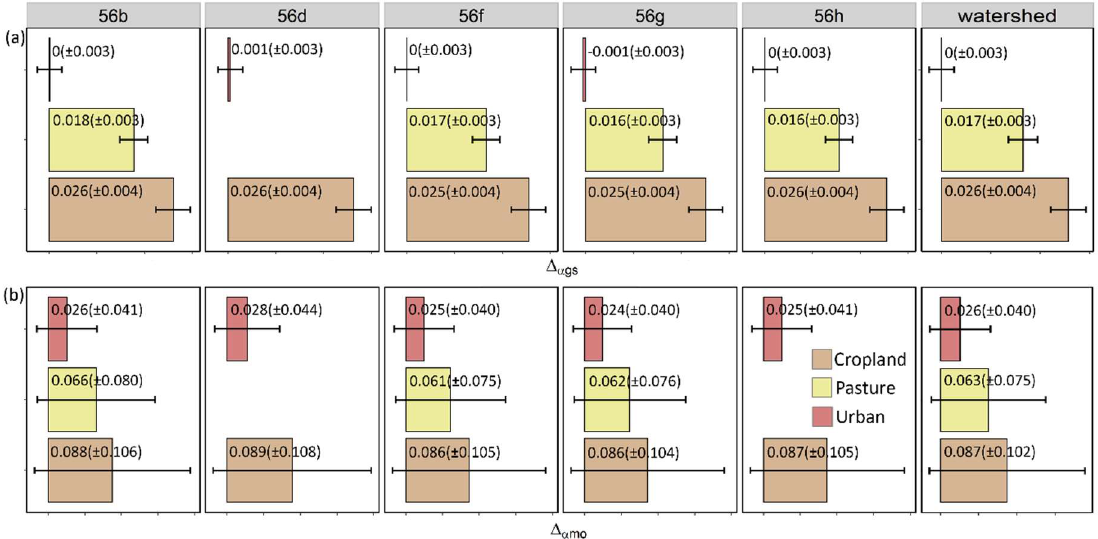
Figure 2. Albedo difference (Δα) between a cover type i and the forest for ( a ) growing season (Δα gs ) and ( b ) monthly (Δα mo ) periods, within the five Level IV ecoregions and the entire Kalamazoo River